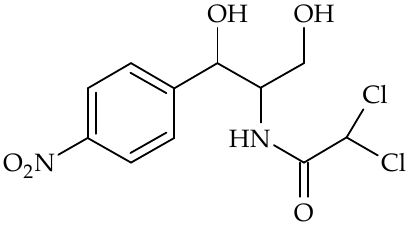
Figure 5. Chemical structure of chloramphenicol.